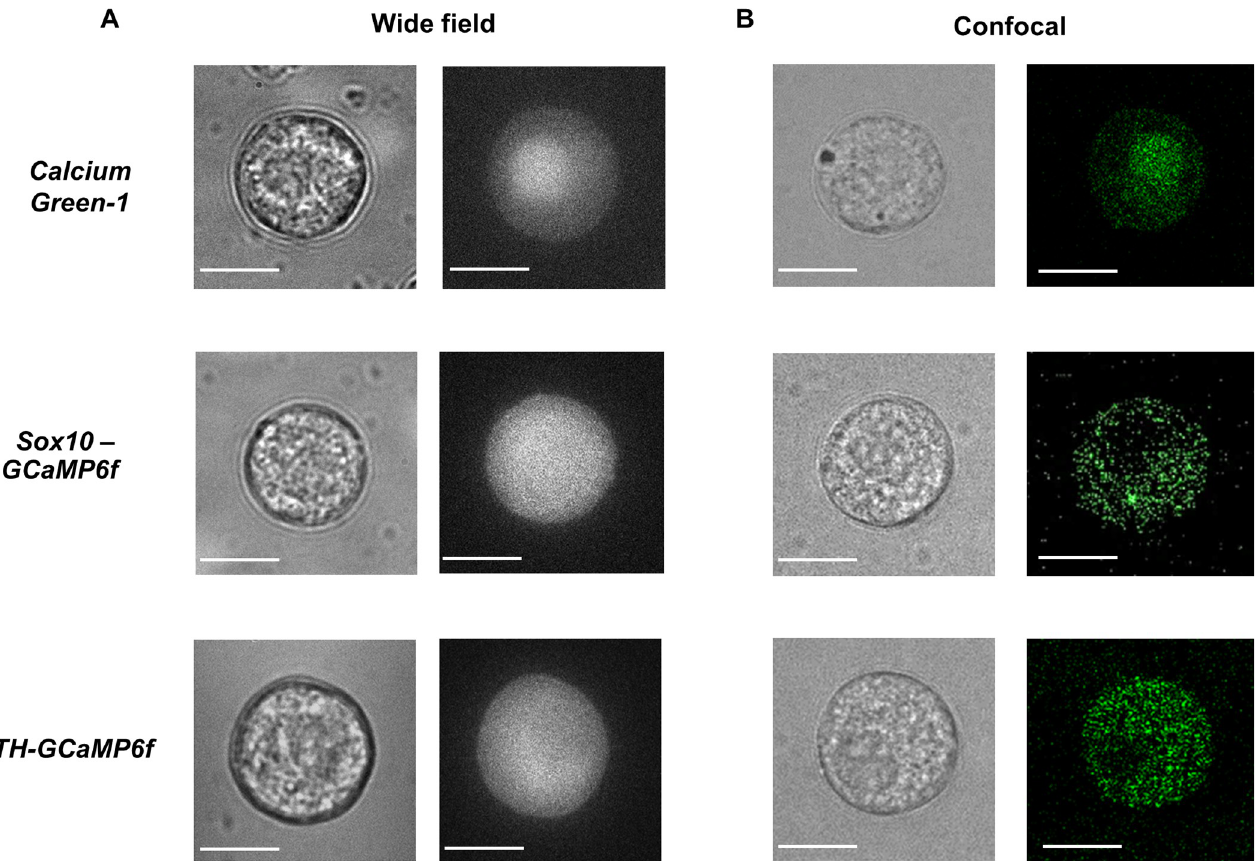
Fig 2. Comparison of brightfield and fluorescence images of Calcium Green-1 loaded and GCaMP6f-expressing ACC. (A) Brightfield and widefield epifluorescence images and (B) brightfield and confocal fluorescence images of wt mouse ACC loaded with Calcium Green-1 (top), GCaMP6f-expressing ACC derived from Sox10-GCaMP6f mice (middle) and GCaMP6f-expressing ACC derived from TH-GCaMP6f mice (bottom). Scale bar = 10 μ m.